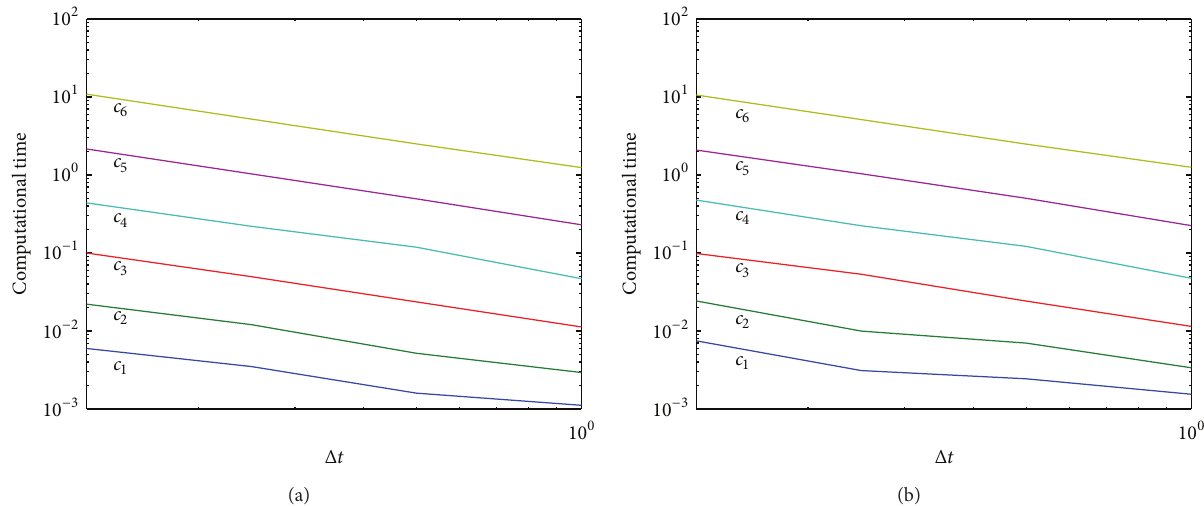
Figure 4: The computational time of the one-sided and two-sided splitting schemes: one-sided splitting over 𝐴 (a) and two-sided splitting scheme alternating between 𝐴 and 𝐵 (b) with 1,. . . , 6 iterative steps.